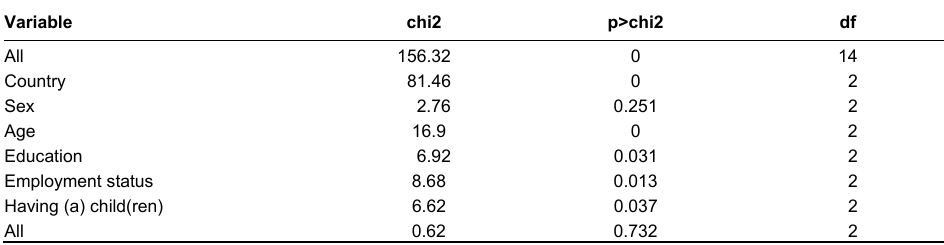
Table 7 : Brant test for the 1999